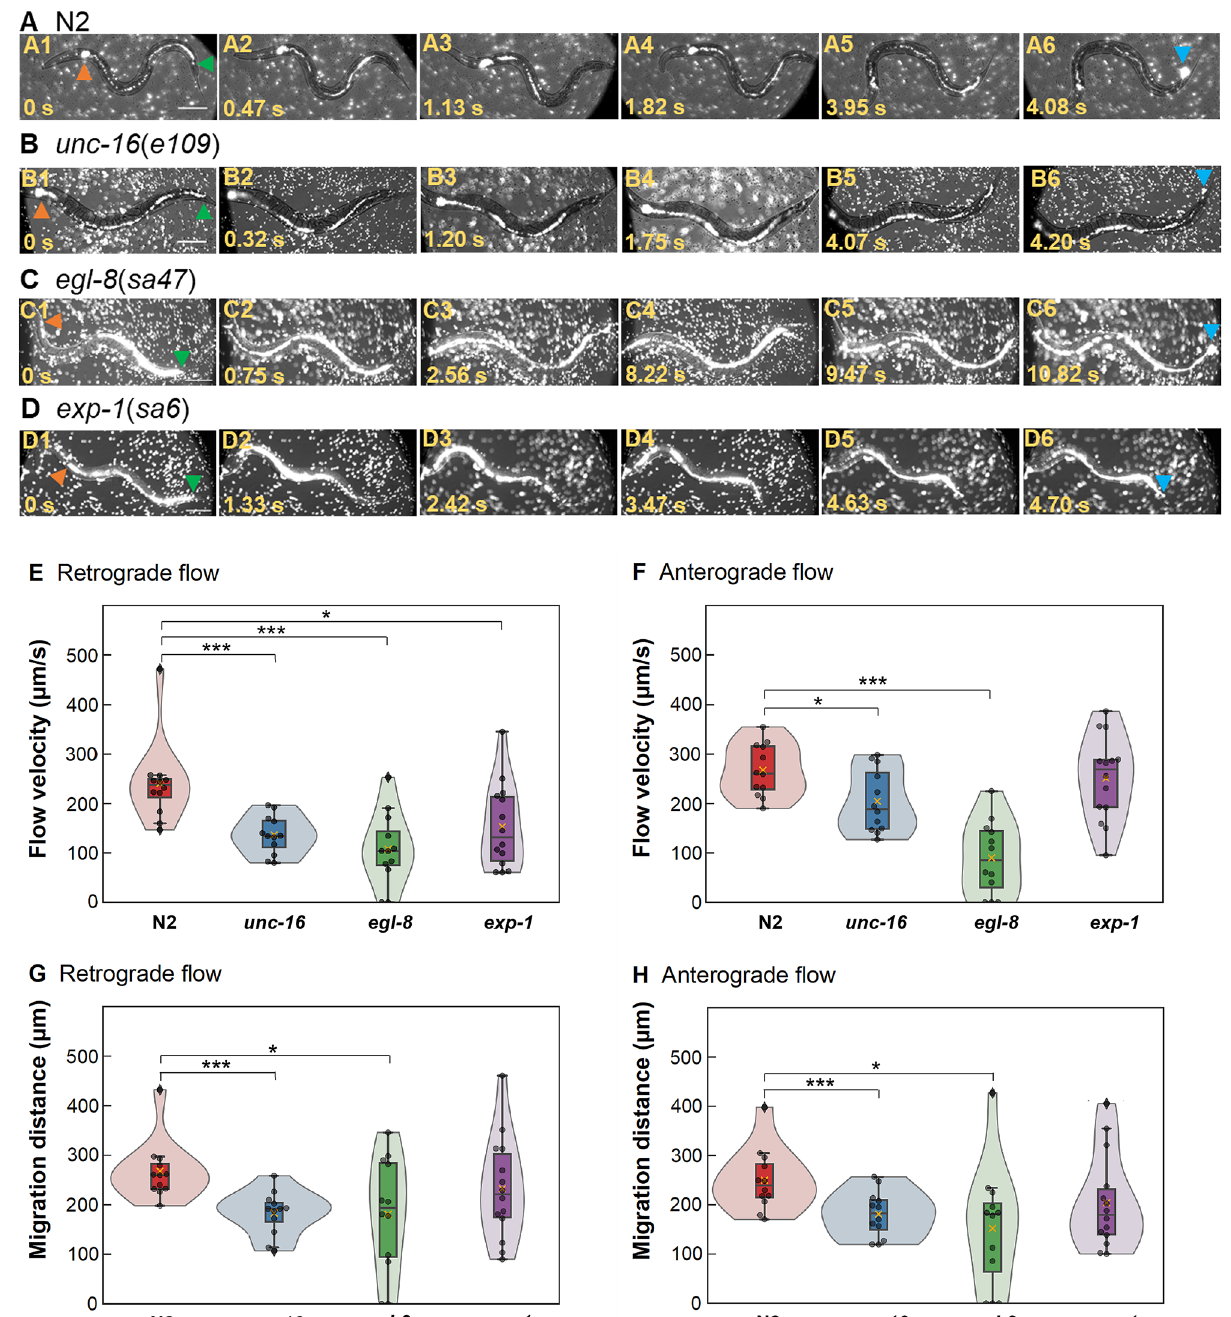
Figure 4. Flows of gut contents during defecation. (A–D) Flow of fluorescent particles (white dots) in the intestine during the DMP. Orange and green arrowheads indicate edges of the anterior and posterior parts of the intestine, respectively; light-blue arrowheads indicate feces expelled from the anus. Elapsed time is shown at bottom left. Scale bar, 100 µm. ( A ) N2. ( B ) unc-16 ( e109 ). ( C ) egl-8 ( sa47 ). ( D ) exp-1 (sa6). ( E, F ) Violin plots of particle retrograde and anterograde flow velocities in the intestine caused by DMP. ( E ) Retrograde flow; n ≥ 12 (each strain). ( F ) Anterograde flow; n ≥ 12 (each strain). ( G, F ) Violin plots of particle migration distances in the intestine by DMP-induced retrograde or anterograde flow. ( G ) Retrograde flow; n ≥ 12 (each strain). ( H ) Anterograde flow; n ≥ 12 (each strain). Data points and a box plot are shown in each violin plot. Cross plots and center lines in box plots denote mean and median values, respectively. Significant differences are indicated by * P < 0.05 and *** P < 0.005 according to Student’s t -test or Welch’s t